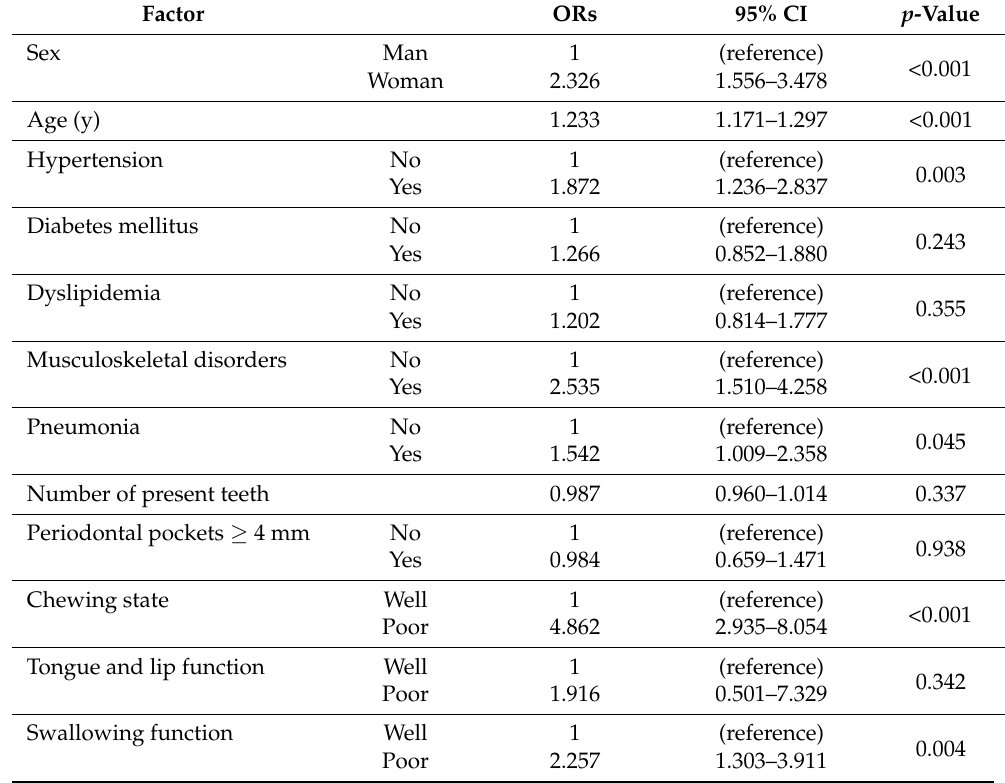
Table 3. Crude odds ratios and 95% CIs for support/care-need certification at follow